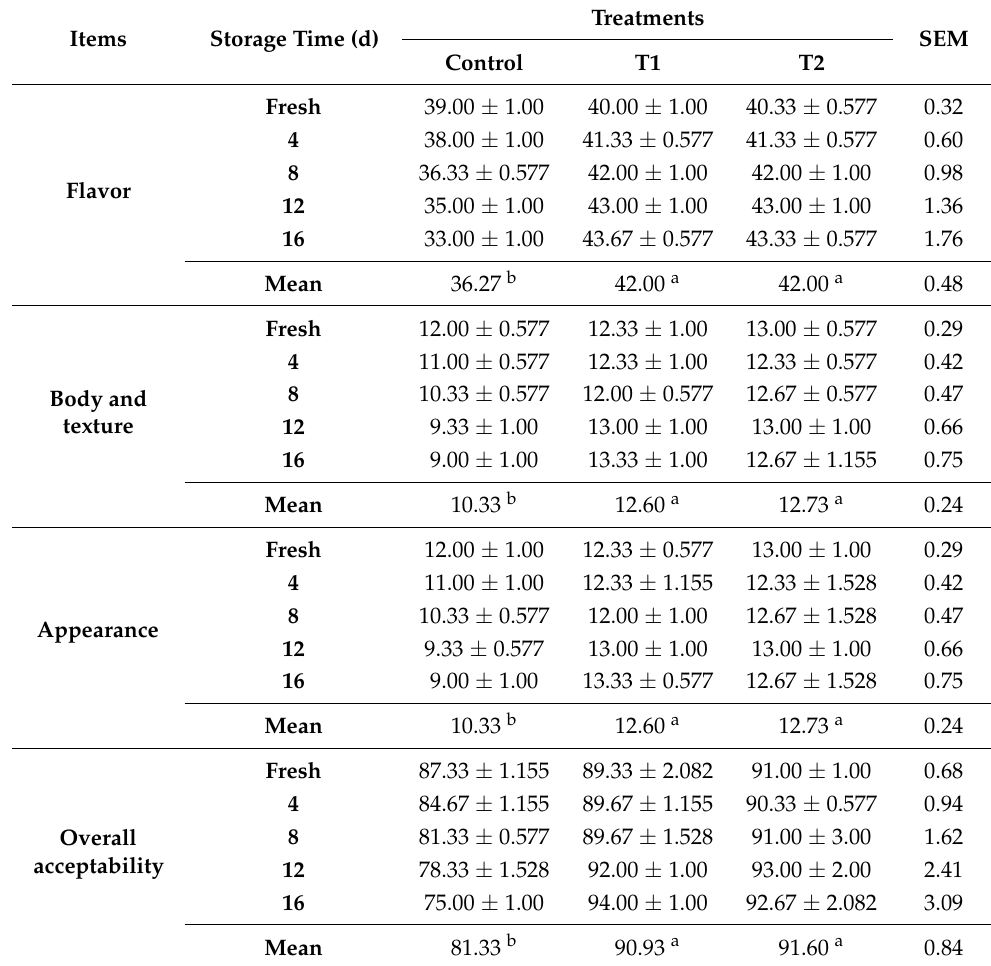
Table 5. Sensory quality properties of SLY samples without and with REO addition (mean ± standard deviation) during storage periods up to 14